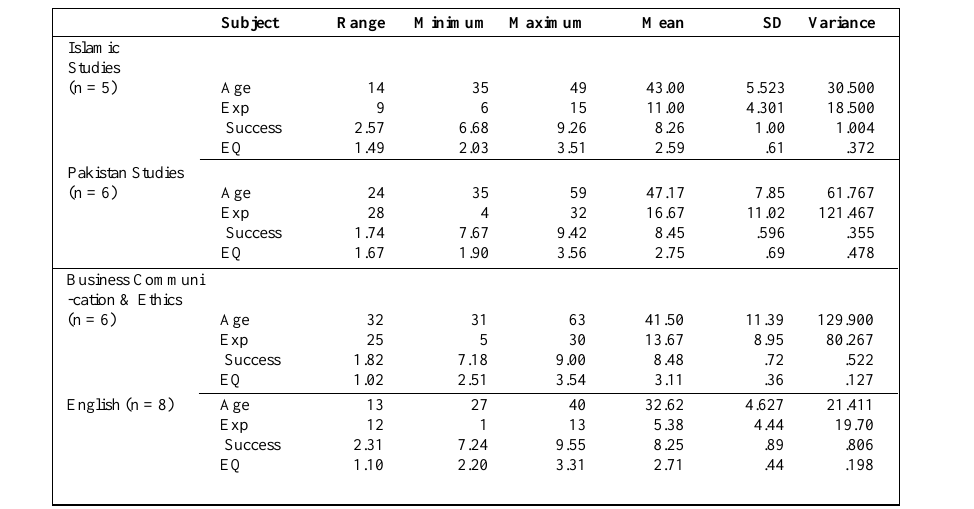
Table 6 Subject-wise Descriptive Statistics of